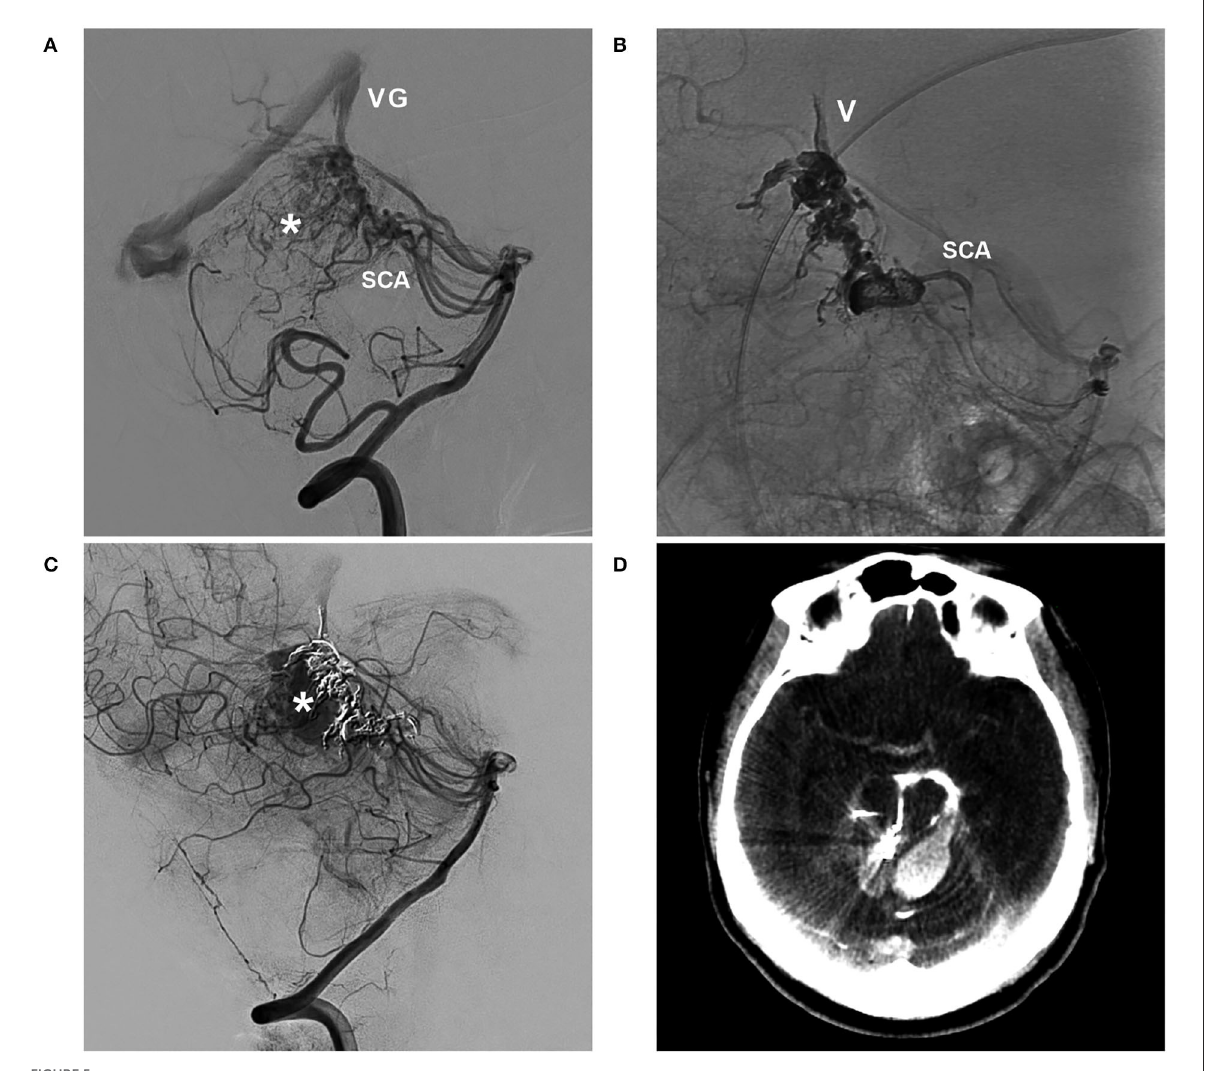
FIGURE5 BAVM with intraoperative rupture of area of perinidal angiogenesis (case 1). (A) Arterial-phase angiogram of the VA showing the BAVM supplied by the SCA, which drains into the VG; the asterisk indicates perinidal angiogenesis. (B) Unsubtracted angiogram of the VA showing Onyx casting in the SCA, nidus, and draining vein (V). (C) Angiogram of the VA showing contrast agent extravasation from intraoperative rupture of the area of perinidal angiogenesis (asterisk). (D) X-per CT showing contrast agent extravasation. BAVM, brain arteriovenous malformation; CT, computed tomography; SCA, superior cerebellar artery; VA, vertebral artery; VG, vein of